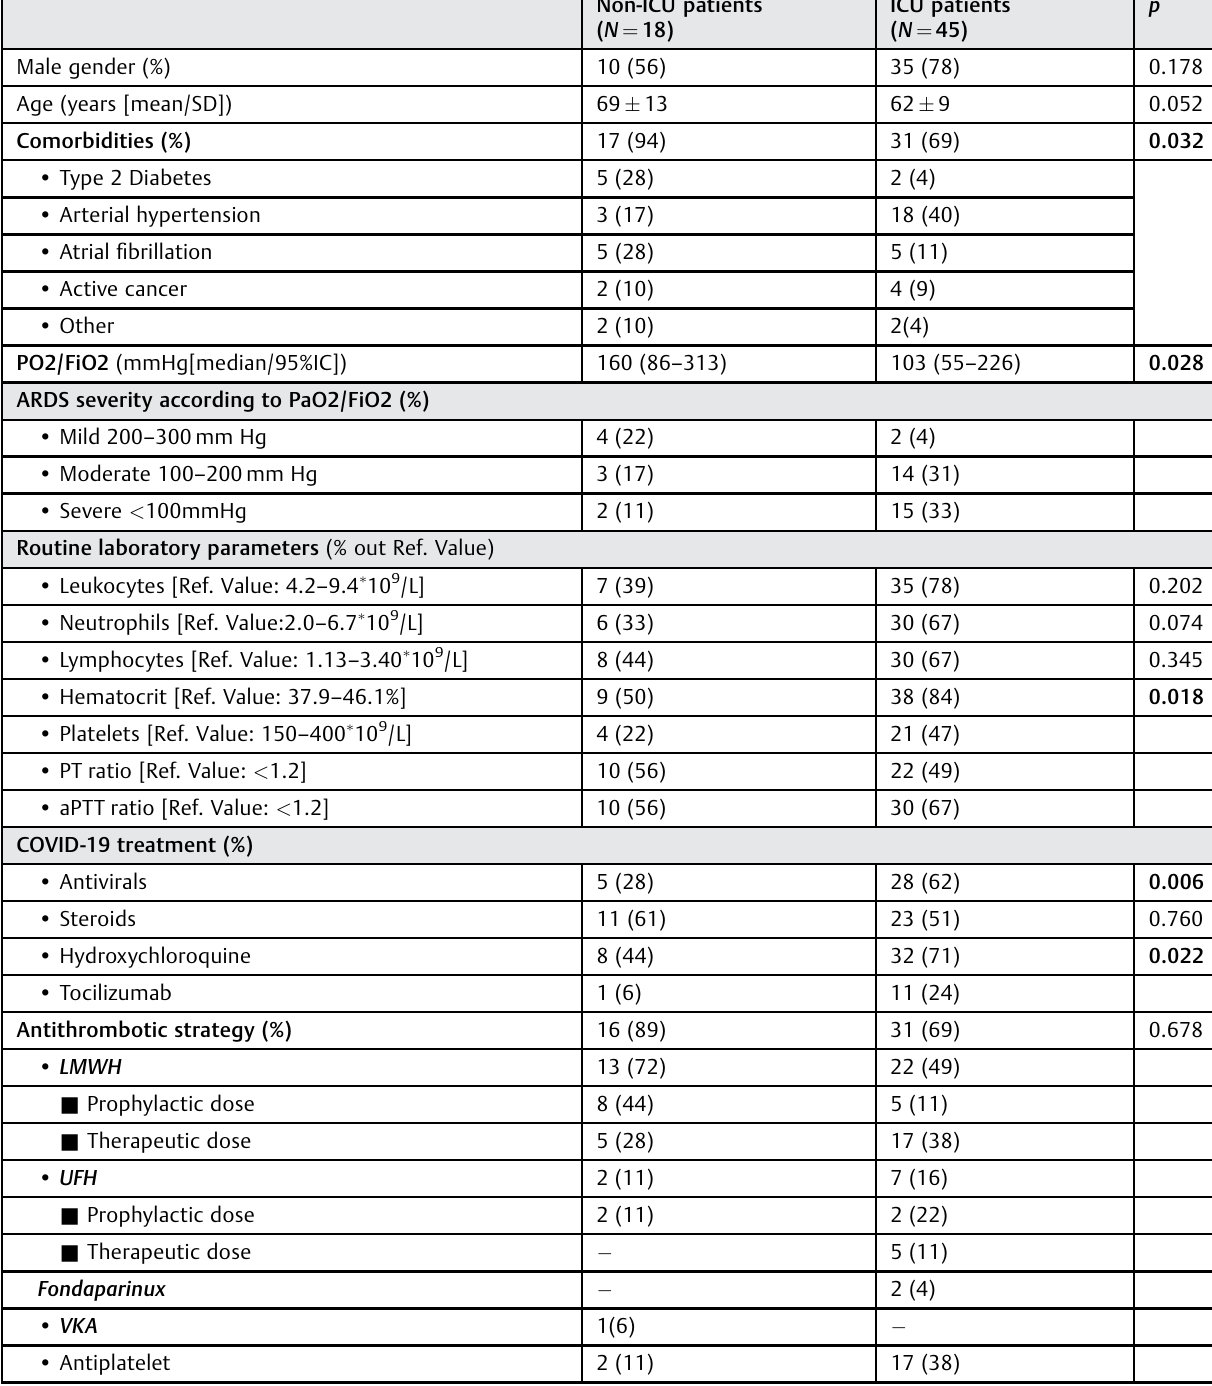
Table 1 Baseline characteristics of the study population according to Non-ICU and ICU hospitalization